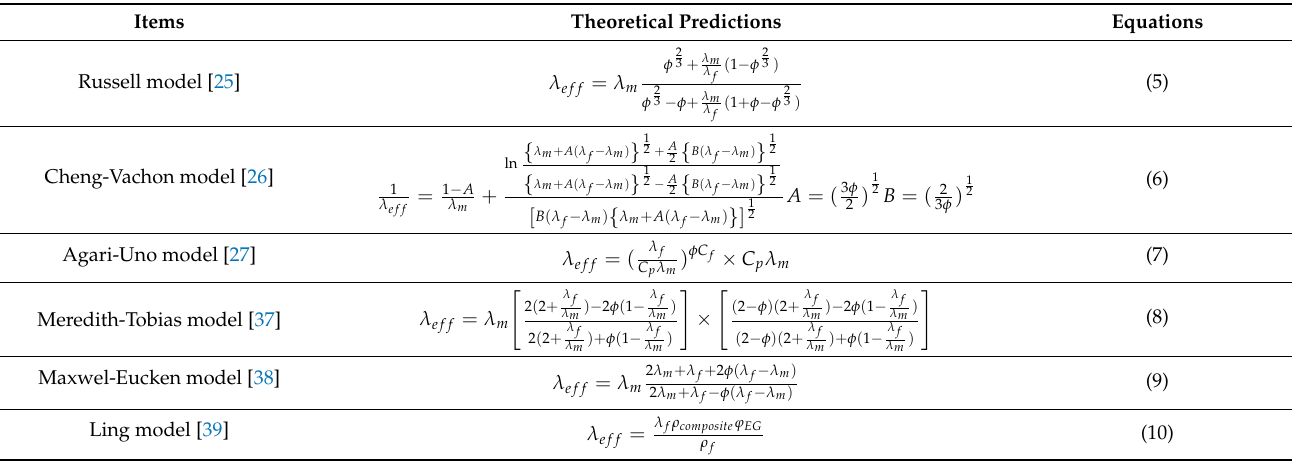
Table 3. Predictions for the effective thermal conductivity of the multiphase composite using theoret- ical models from the